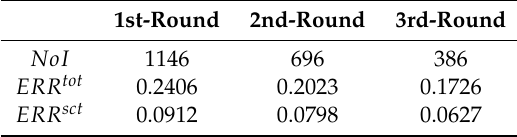
Figure 7. Reconstructed results for the “Austria” profile at 800 MHz by the WT-TSOM. ( a – c ) Reconstructed results correspond to three rounds of optimization, respectively. The real ( first row ) and imaginary ( second row ) of the reconstructed results. The 1st, 2nd, and 3rd rounds of optimization correspond to β being 6, 3, and 0.5, coupled with M w being 256, 512, and 768, respectively. Table 5. Errors of the reconstructed results by